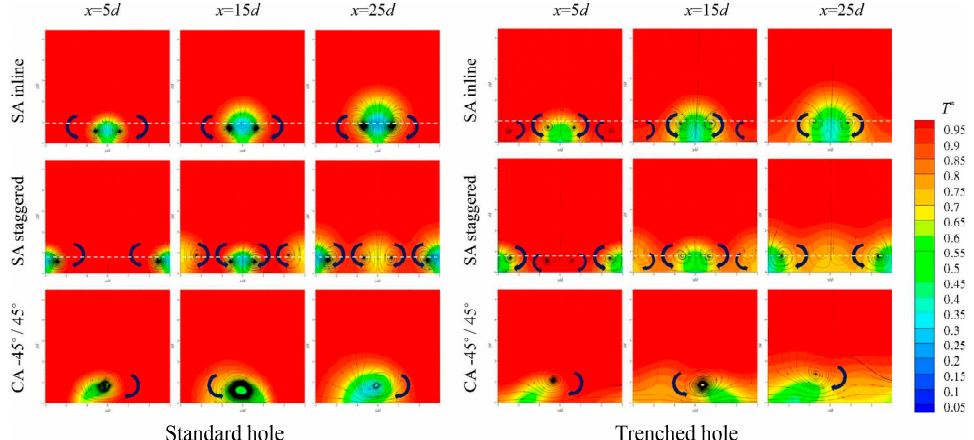
Figure 13. Dimensionless temperature contour overlaid with streamlines in the specific cross sections of various effusion cooling configurations. Adapted with permission from [88]. Licensed under a Creative Commons Attribution (CC BY) license.